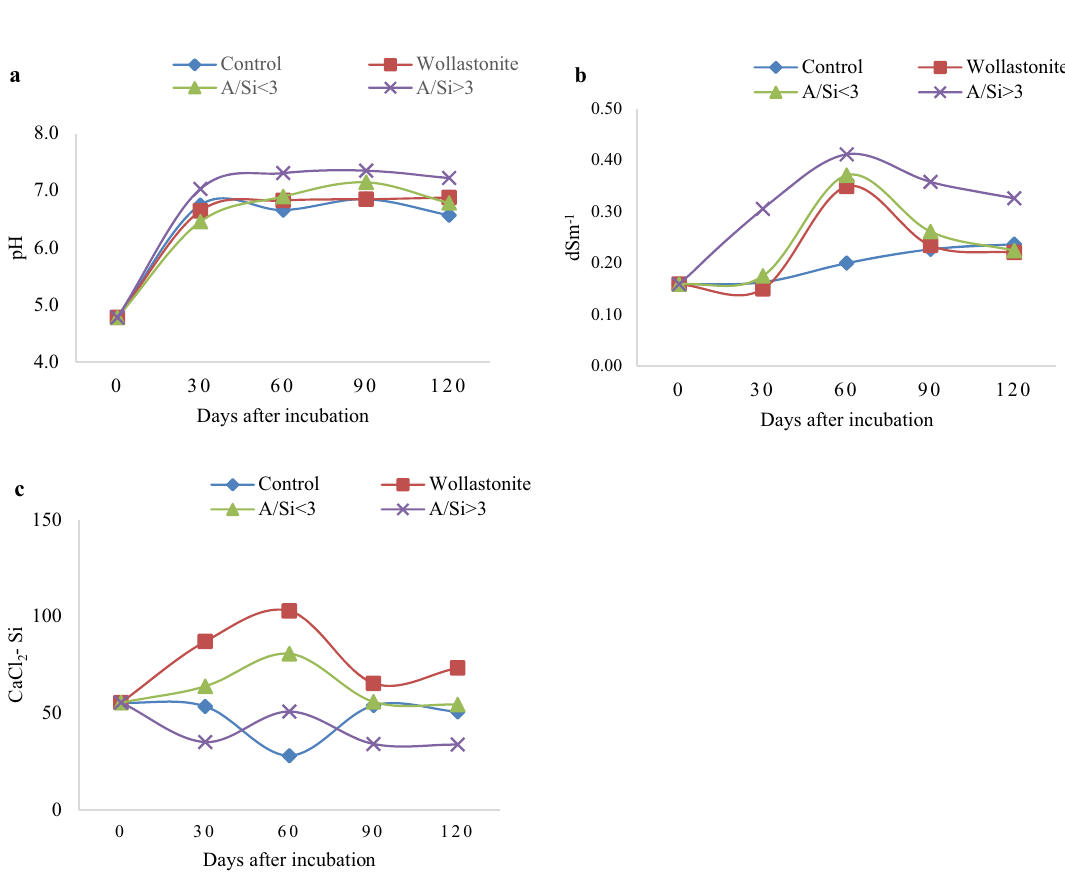
Figure 2. Change in pH ( a ), EC ( b ) and concentration of extractable Si ( c ) at different days after incubation in soil with the addition of different silicate sources. (each data represents an average of three replication; A/ Si < 3-average of treatment with caster slag, furnace slag and EAF slag; A/Si > 3-average of treatment with laddle slag-2, laddle slag-3 and desulfurization slag replicated